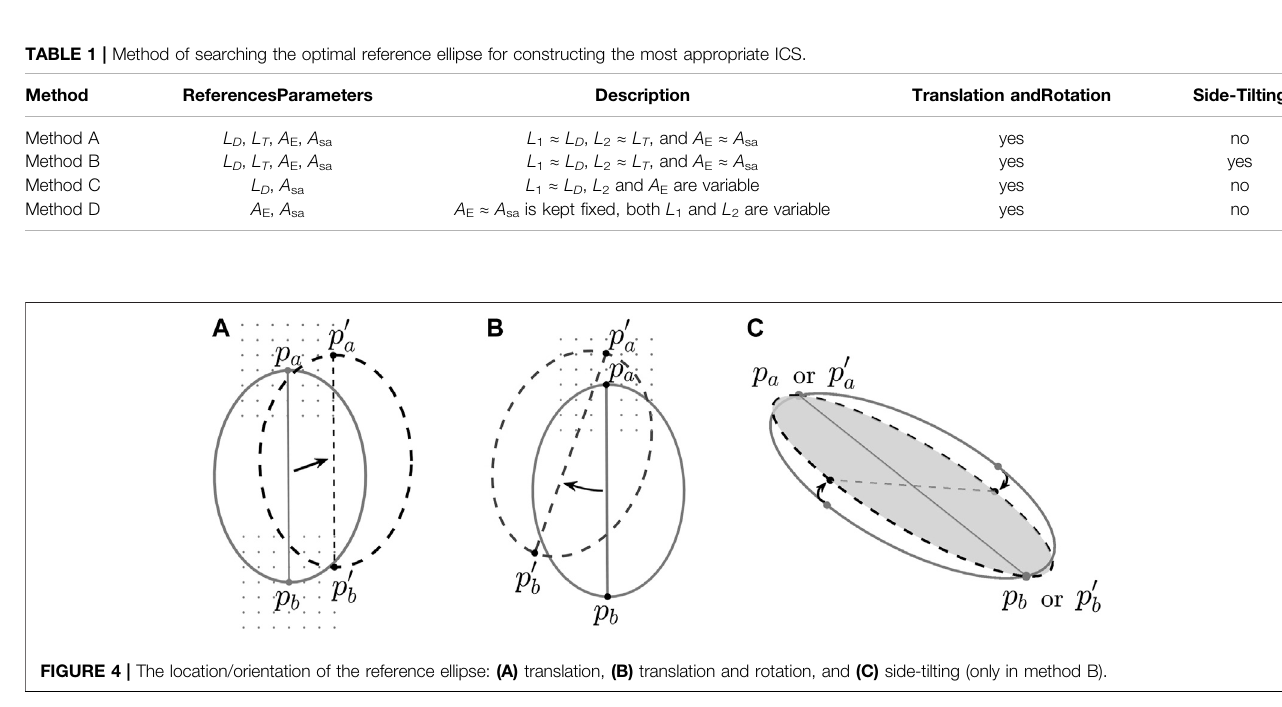
Frontiers in Earth Science |